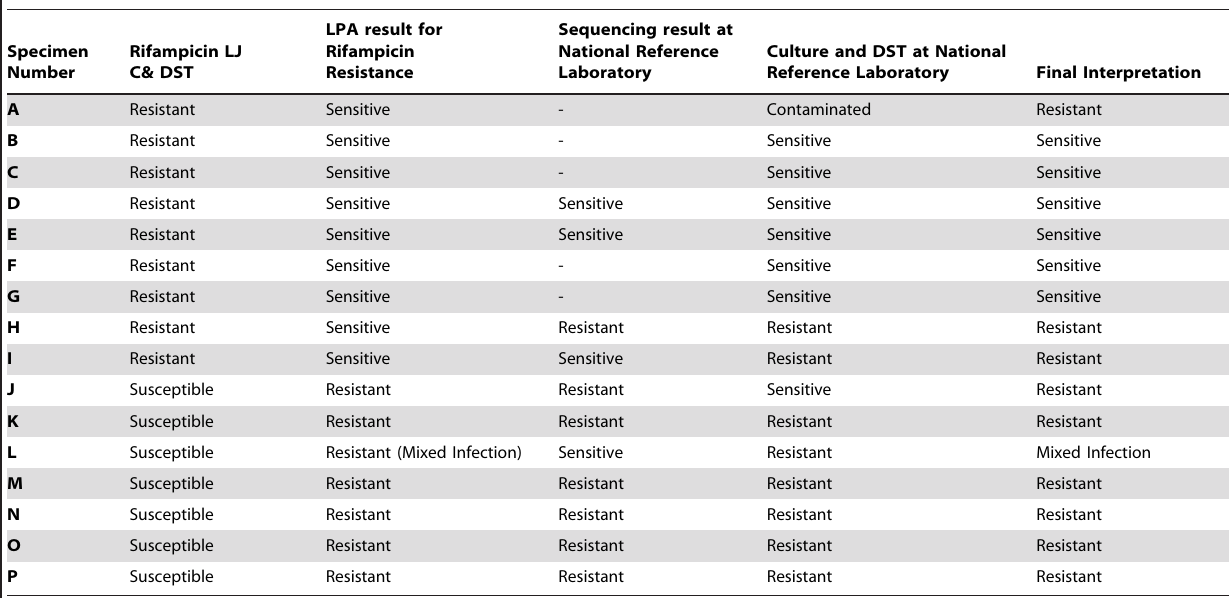
Table 5. Results of discordance resolution at national reference laboratory.